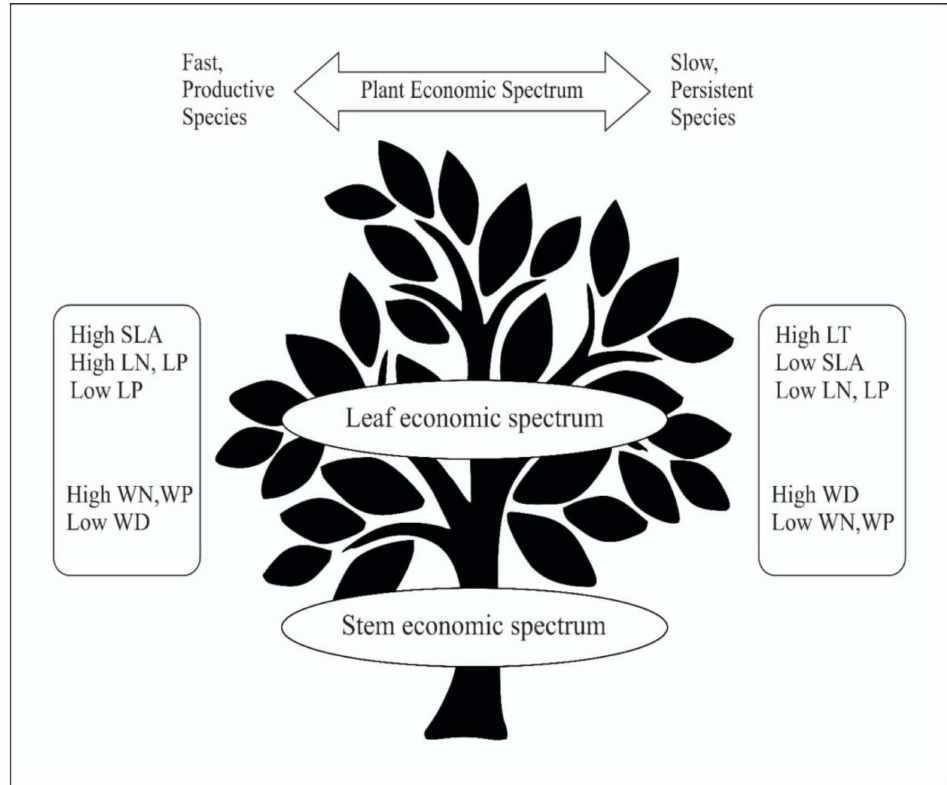
Figure 6. Conceptual illustration of the plant economic spectrum